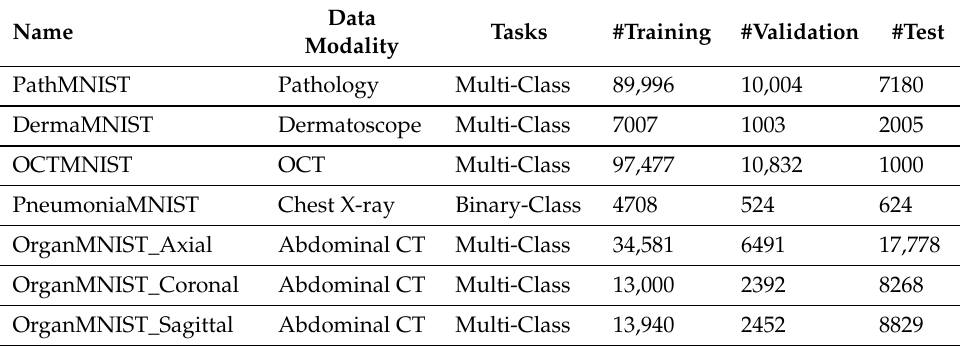
Table 1. Datasets in MedMNIST used in our